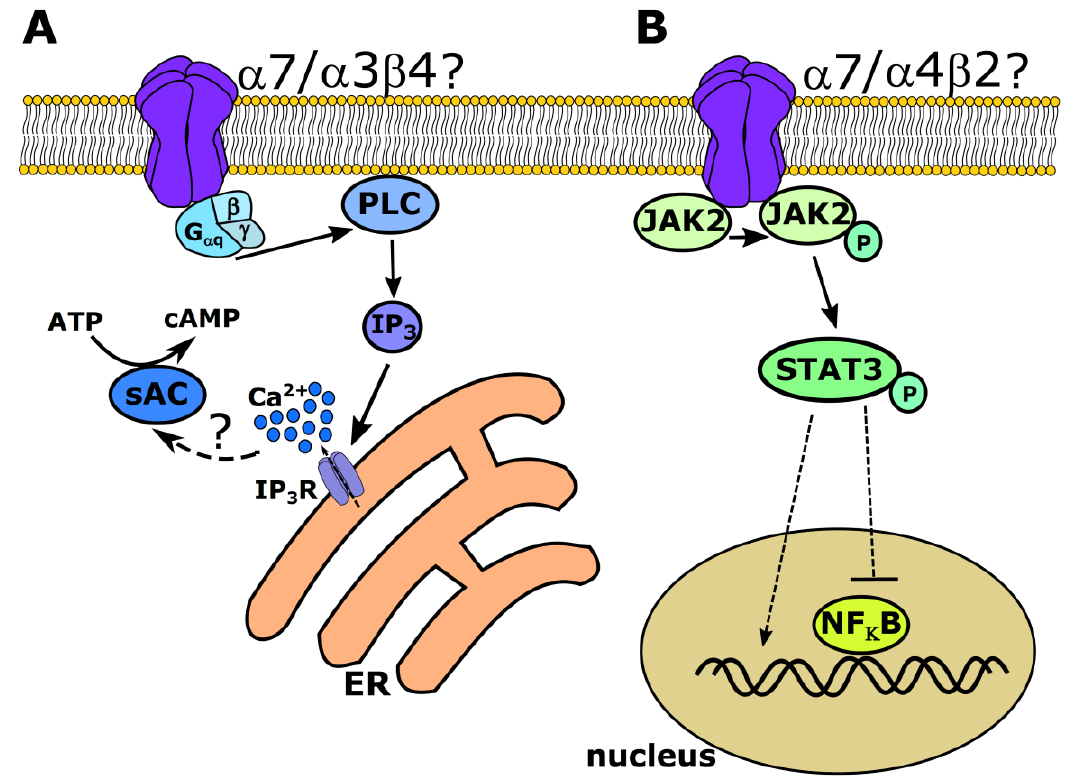
Figure 1. Examples of possible metabotropic signaling pathways for nicotinic acetylcholine receptors (nAChR). ( A ) The α 7 nAChR have been shown to couple to G α q proteins, which then activates phospholipase C β 2 (PLC), resulting in an inositol 1,4,5-trisphosphate (IP 3 )-dependent release of Ca 2+ from intracellular stores. The α 3 β 4 nAChR in the airway epithelium have also been shown to act via a metabotropic IP 3 -dependent release of intracellular Ca 2+ by a yet uninvestigated pathway, which might then lead to the activation of Ca 2+ -dependent soluble adenylyl cyclases (sAC), increasing intracellular cAMP. ( B ) The α 7 nAChR may also be coupled to Janus kinase 2 (JAK2) and may activate the signal transducer and activator of transcription 3 (STAT3), which then either regulates gene expression itself or inhibits NF κ B. Additionally, for α 4 β 2 receptors, JAK2/STAT3-dependent signaling has been described but not fully elucidated.